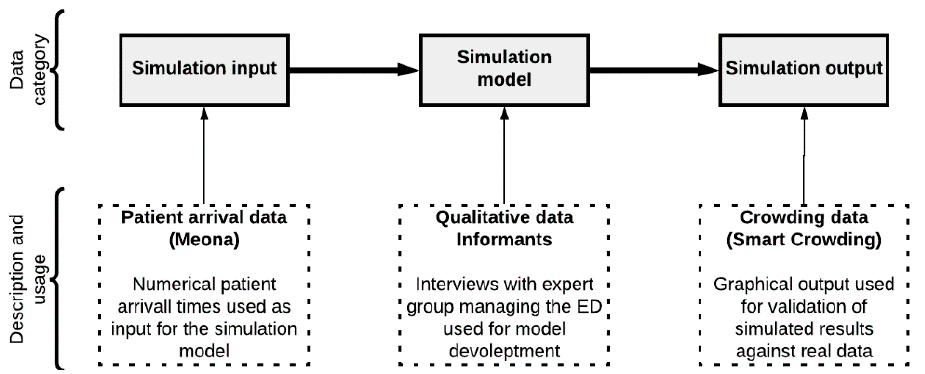
Figure 1. The data categories used in constructing, running, and validating the simulation model.